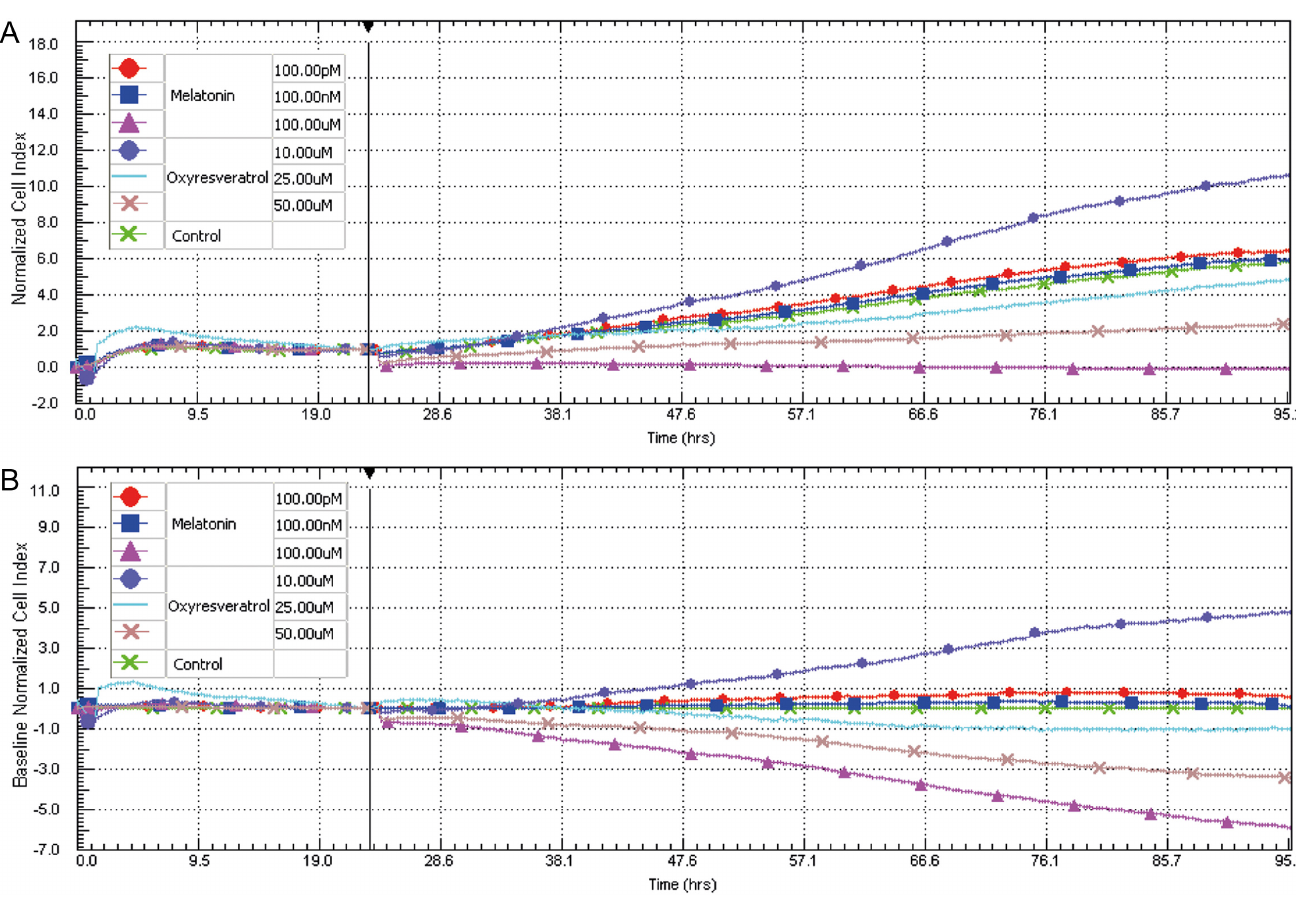
Figure 1. A, B. (A) Cell index change and (B) standardized cell index change compared to the control group observed in xCELLigence® for 72 hours following the addition of melatonin and oxyresveratrol to DPSCs at the 24th hour.DPSCs, dental pulp stem